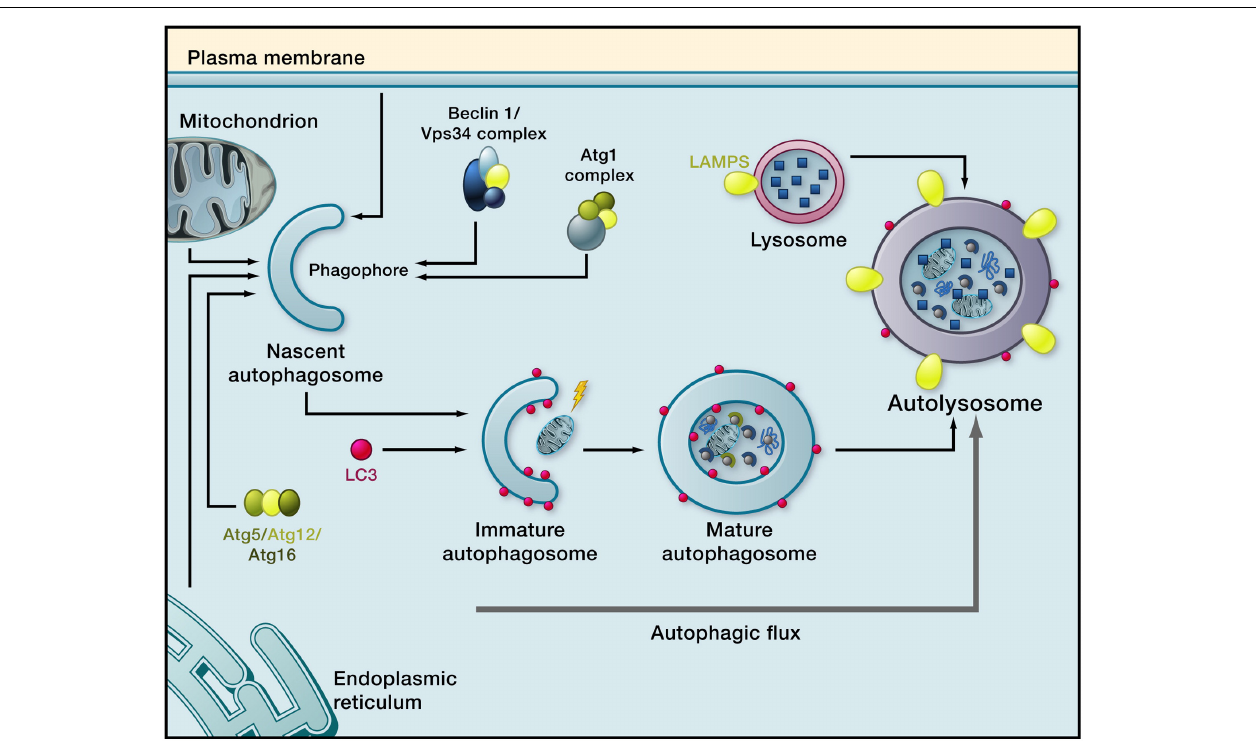
FIGURE 1 | Macroautophagy. Induction of macroautophagy results in phagophore formation, which requires the kinase Vps34 (functioning in a complex that contains Atg6, whose mammalian homolog is Beclin 1). This is followed by phagophore membrane elongation, which is regulated by LC3-II. The phagophore closes around sequestered cargo, resulting in formation of a mature autophagosome. The autophagosome moves along microtubules to a lysosome and fuses with it. Cargo is then degraded by lysosomal enzymes and breakdown products are recycled to the cytosol. The complete process is termed autophagy flux (Reprinted from Rubinsztein et al.,